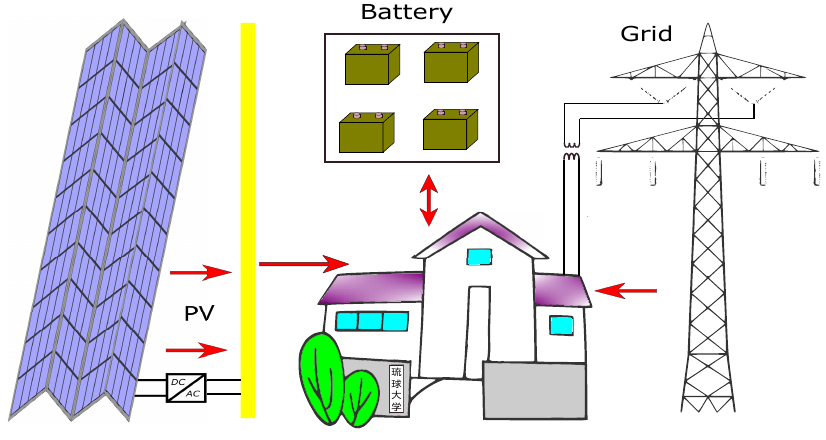
Figure 1. The proposed micro-grid system